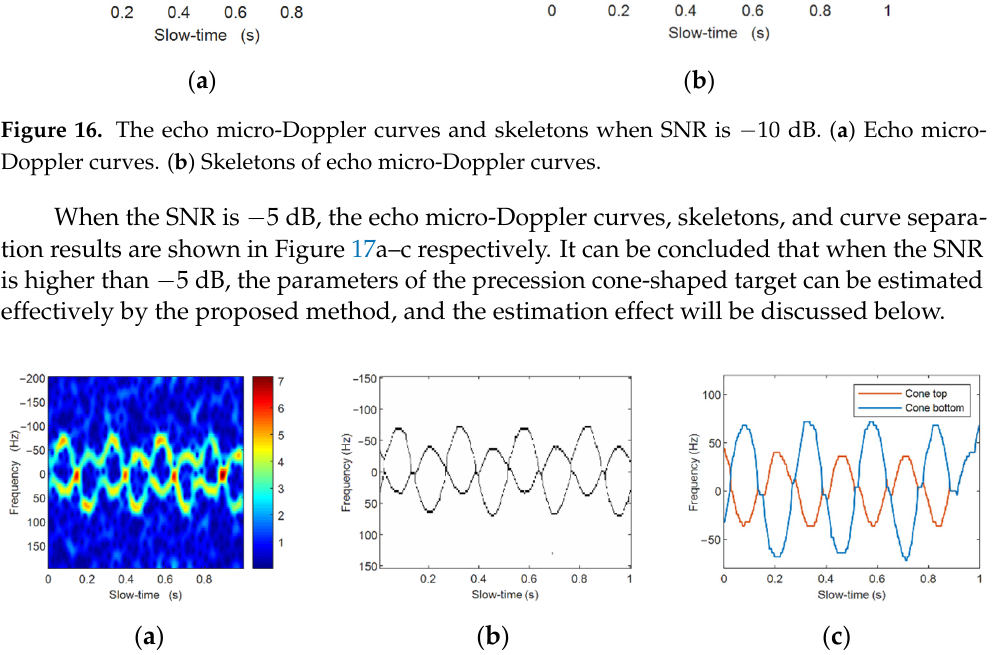
Figure 17. The echo micro-Doppler curves, skeletons and curve separation results when SNR is − 5 dB. ( a ) Echo micro-Doppler curves. ( b ) Skeletons of echo micro-Doppler curves. ( c ) Curve separation results.